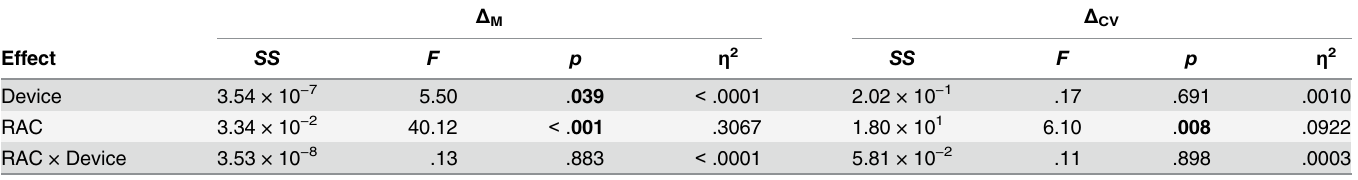
Table 7. Statistics associated with the RAC × Device ANOVA for step time outcome measures in PD patients.